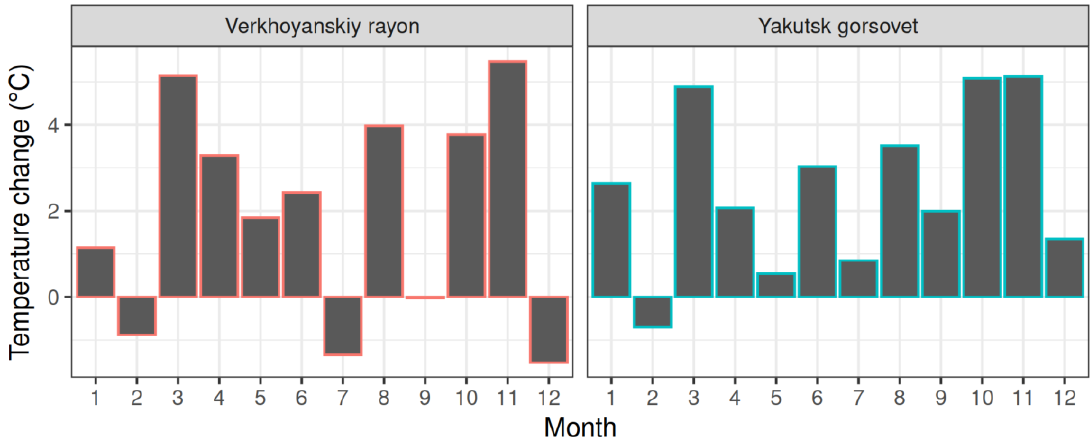
Figure 4. Changes in monthly temperature between 1981–1982 and 2017–2018, for the districts Verkhoyanskiy rayon and Yakutsk gorsovet in the Republic of Sakha.